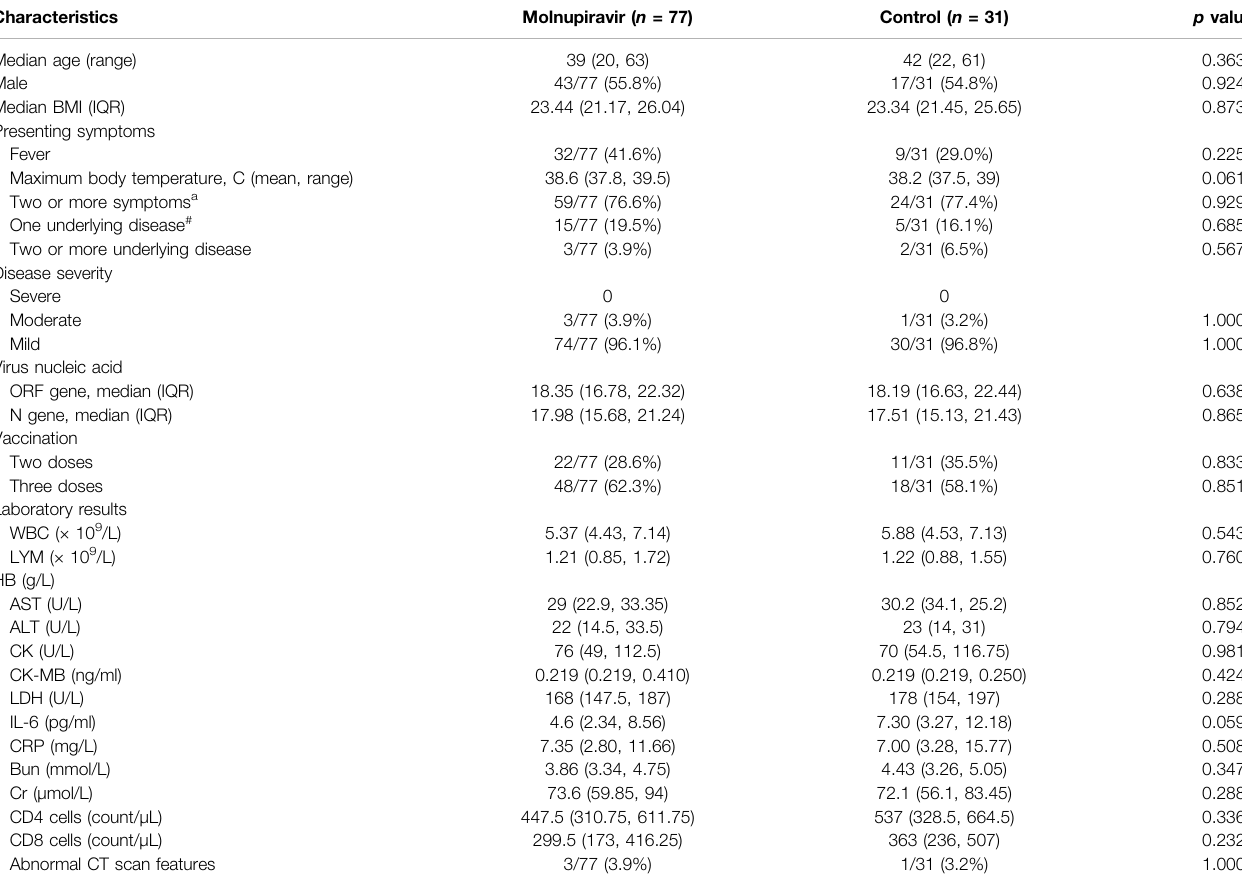
TABLE 1 | Patient demographics and clinical characteristics at baseline.